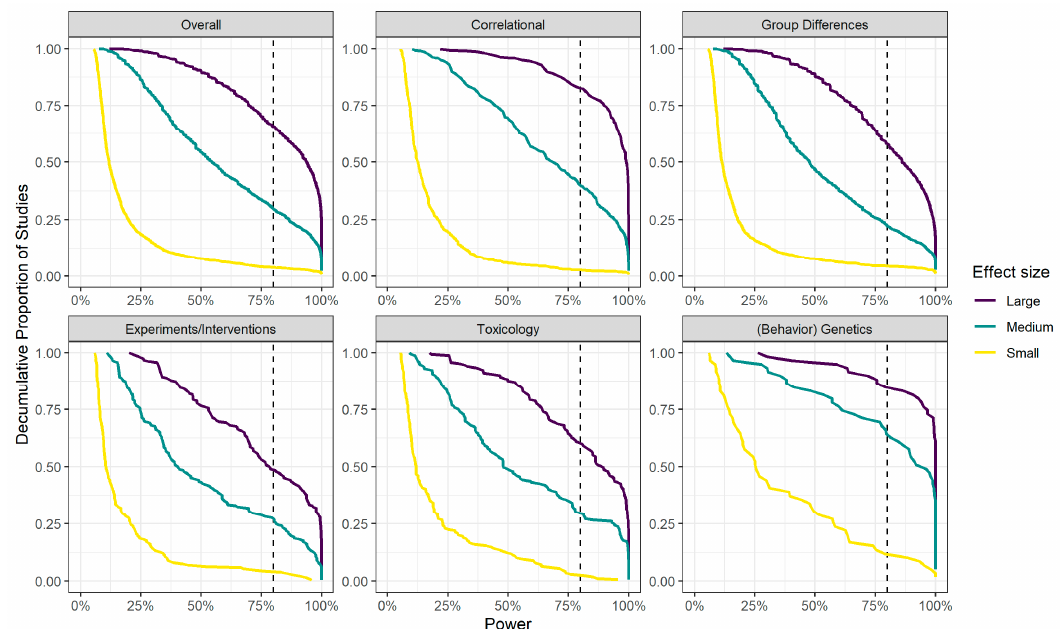
Figure 3. Decumulative proportion of primary studies that had at least a certain power to detect a large, medium, or small effect, split up per study type and overall. The vertical dotted line indicates the nominal power of 80%. Small, medium, and large effects correspond to a Pearson’s r of 0.1, 0.3, and 0.5 or a Cohen’s d of 0.2, 0.5, and 0.8, respectively.